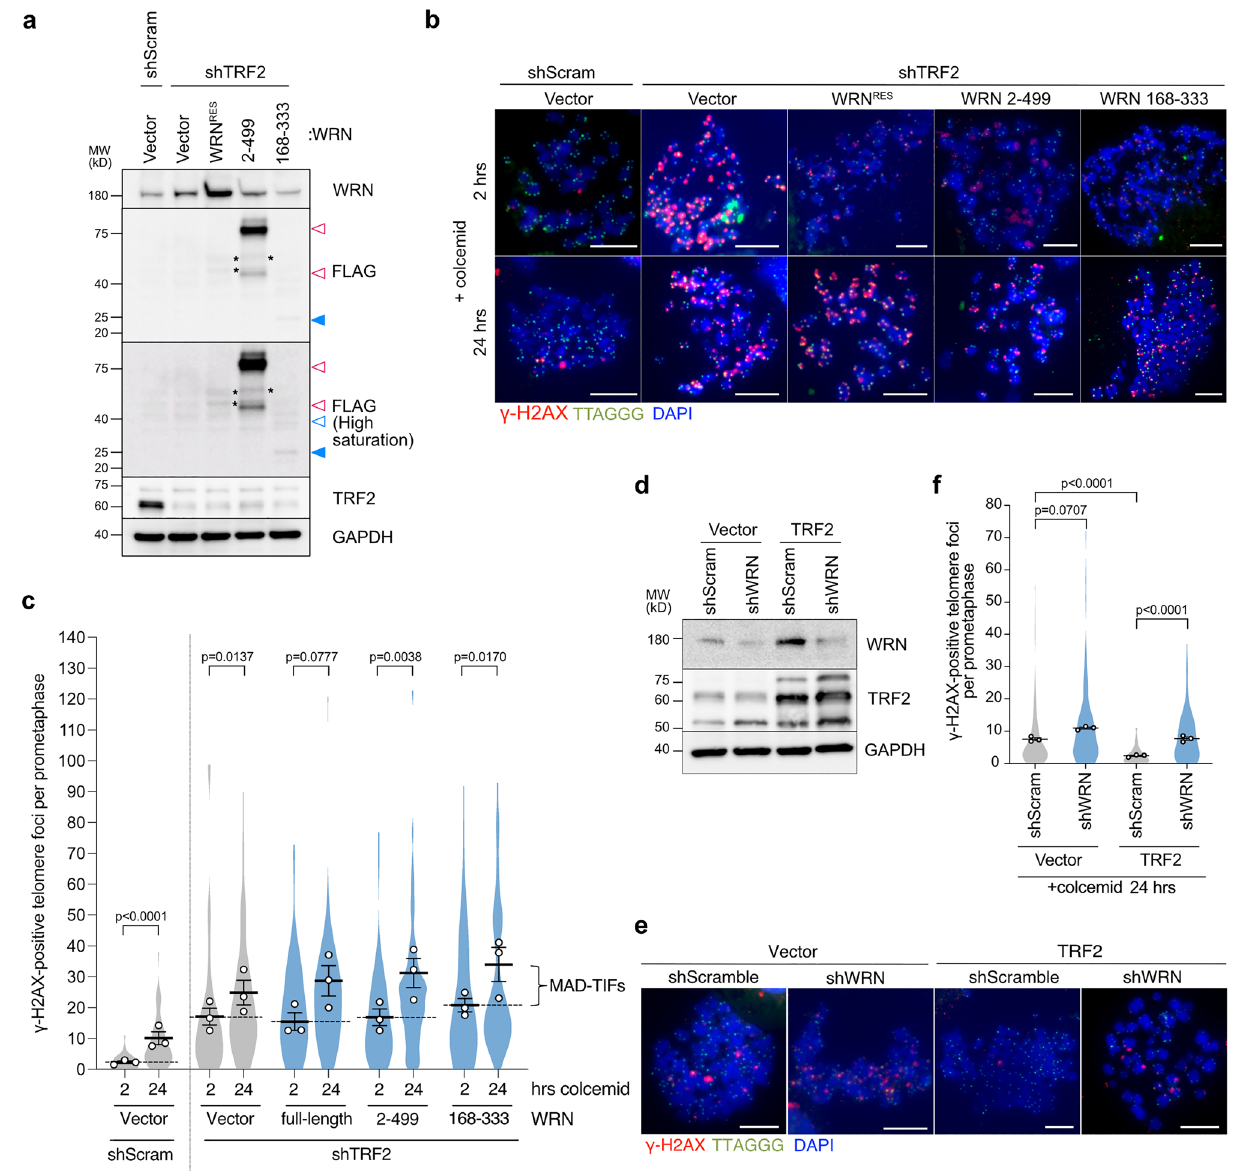
Figure 4. WRN supports TRF2 function to protect mitotic telomeres. ( a ) Immunoblot of endogenous WRN, FLAG-WRN fragments, and TRF2 upon TRF2 depletion in indicated cells. IMR-90 E6E7 hTERT cells expressing indicated WRN fragments were transduced with shTRF2 lentivirus and analyzed on day 7 post-infection. Blue-colored arrowhead indicates the expected size for WRN 168–333 (~ 27 kDa). White arrowheads (magenta line border for WRN 2–499 fragment and blue border for WRN 168–333 ) indicate possible post-translational modifications or complex formation. GAPDH serves as a loading control. ( b ) Representative images of meta-TIF assay from TRF2 knockdown cells expressing indicated WRN fragments after treatment with 100 ng/ml colcemid. The images show DAPI (blue), γ-H2AX (red), and telomere FISH (green). Scale bar, 10 µm. ( c ) Quantification of telomeric signals colocalized with γ-H2AX foci in indicated conditions as shown in Fig. 1c (n = 15/experiment for 2 h colcemid; n = 30/experiment for 24 h colcemid; mean ± s.e.m.; Mann–Whitney test). Dashed lines discriminate between the average number of TIFs generated in the interphase due to shTRF2 (2 h colcemid) and MAD-TIFs caused by mitotic arrest (24 h colcemid). ( d ) Immunoblot of endogenous WRN and TRF2 in indicated cells. IMR-90 E6E7 hTERT cells expressing exogenous TRF2 were transduced with shWRN lentivirus and analyzed on day 5 post-infection. GAPDH serves as a loading control. ( e ) Representative images of meta-TIF assay in indicated cells from d after treatment with 100 ng/ml colcemid for 24 h. The images show DAPI (blue), γ-H2AX (red), and telomere FISH (green). Scale bar, 10 µm. ( f ) Quantification of telomeric signals colocalized with γ-H2AX foci in indicated conditions as shown in Fig. 1c (n = 30/experiment; mean ± s.e.m.; Kruskal–Wallis followed by Dunn’s test). Unprocessed blot images are shown in Supplementary Information